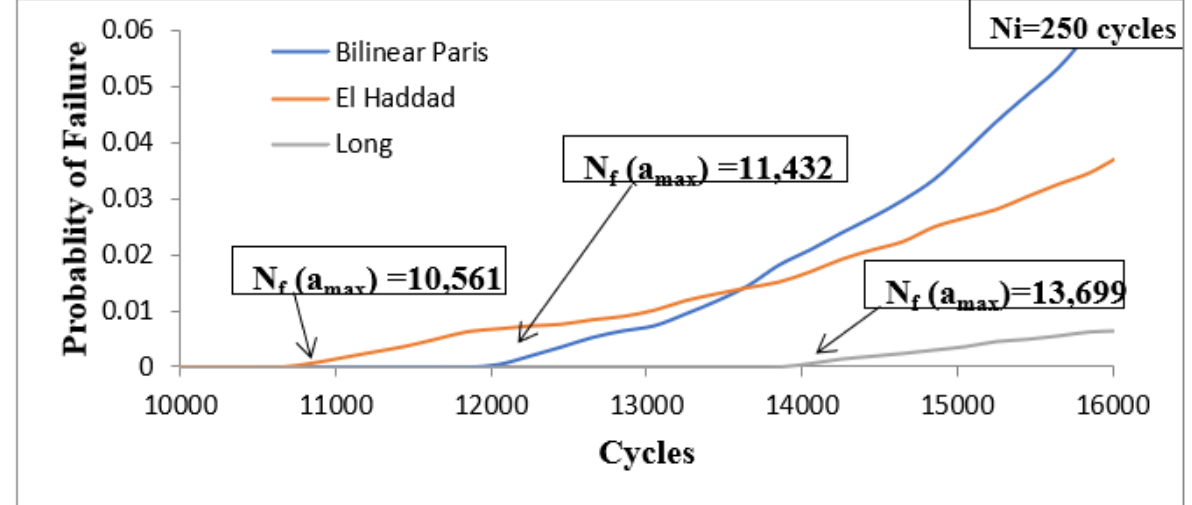
Figure 14. Probability of Failure of two short FCG models.